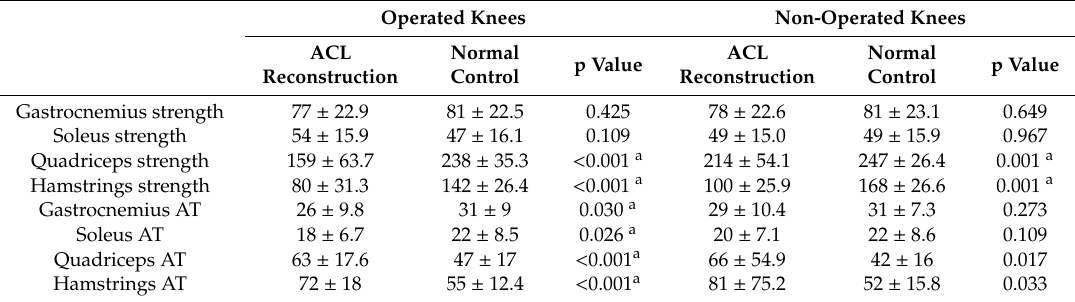
Table 3. Muscle strength and acceleration time of both knees for patients having ACL reconstruction on one knee (postoperative one year) and normal control